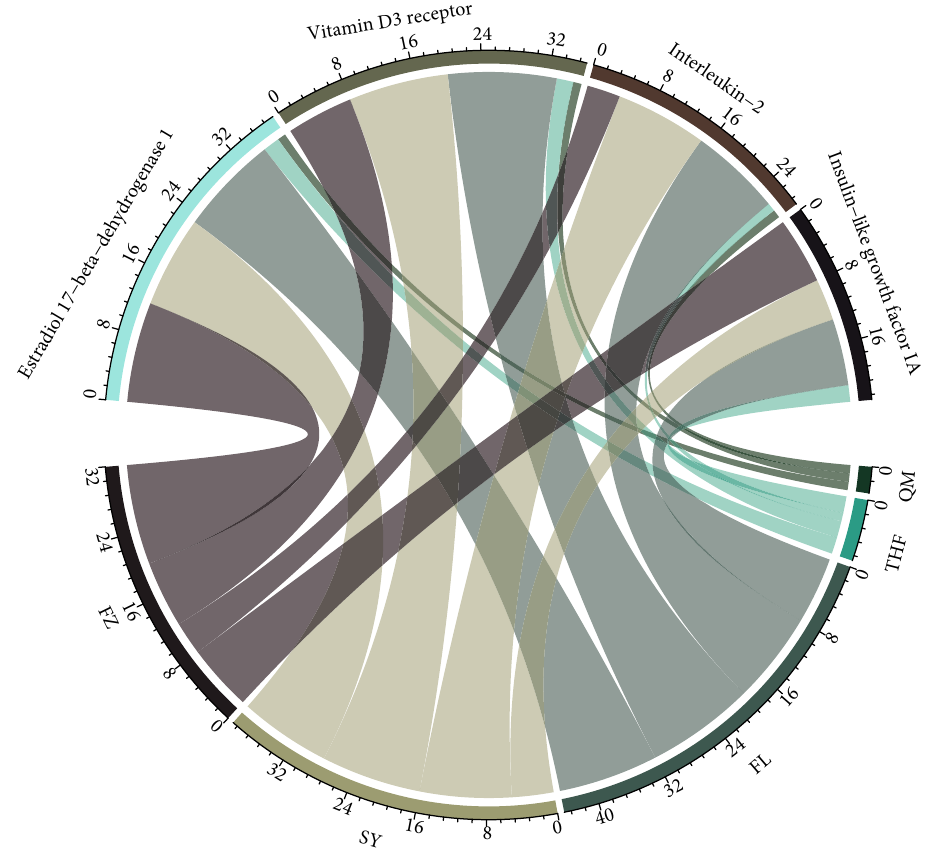
Figure 7: Correspondence between GLQMW and main target